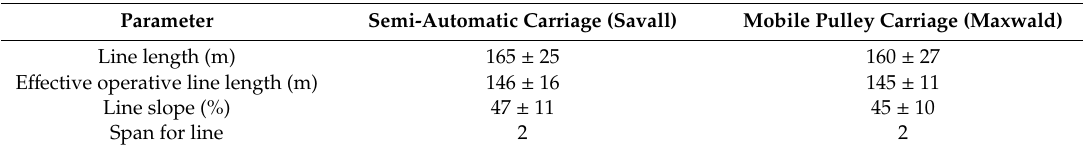
Table 4. Technical description (average ± standard deviation) of the wood extraction lines in two logging